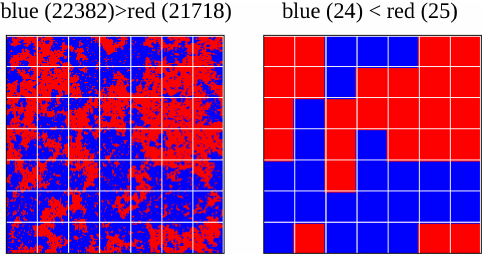
Fig. 2. Snapshots of the spatial organizations of the opinion values prior to (left) and after (right) the coarse graining are shown. Up-spins are in the majority (blue 22382, red 21718) prior to coarse graining, in the original system. But as there is strong spatial correlations, in the coarse-grained system the down spins become the majority (from Ref.